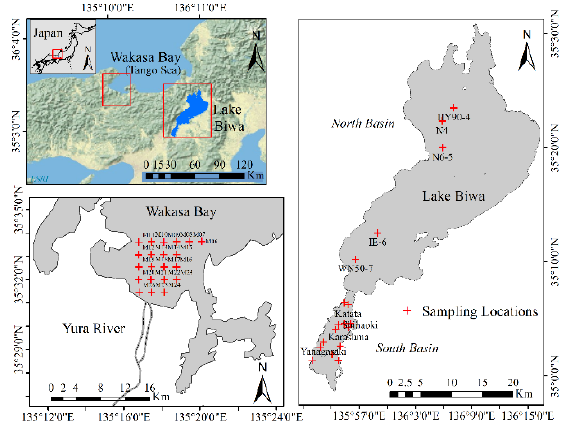
Figure 1. Geographical location of the freshwater lake (Lake Biwa) and coastal water (Wakasa Bay) in